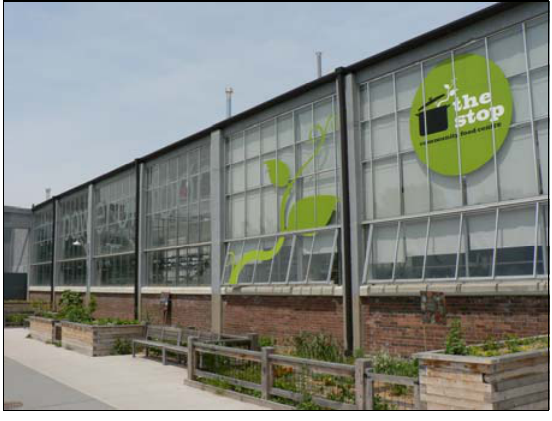
(Photo credit: Charles Z.